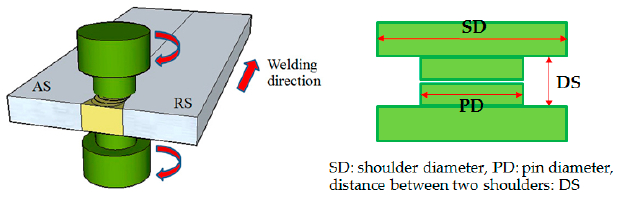
Figure 1. Schematics of the friction stir welding (FSW).